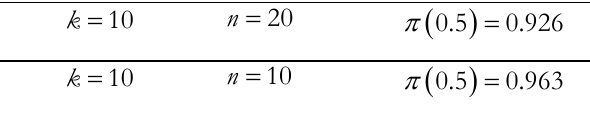
Prevision index in a Bayesian test